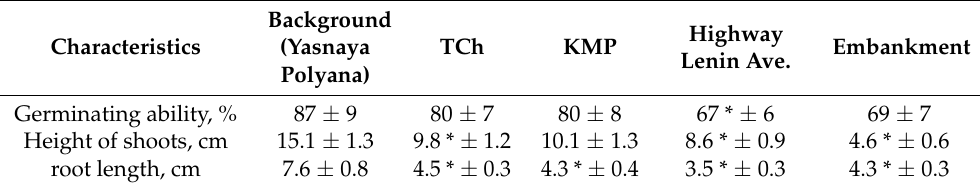
Table 2. Effect of soil pollution with heavy meals on germinating ability and biometric parameters of Echinochloa frumentacea